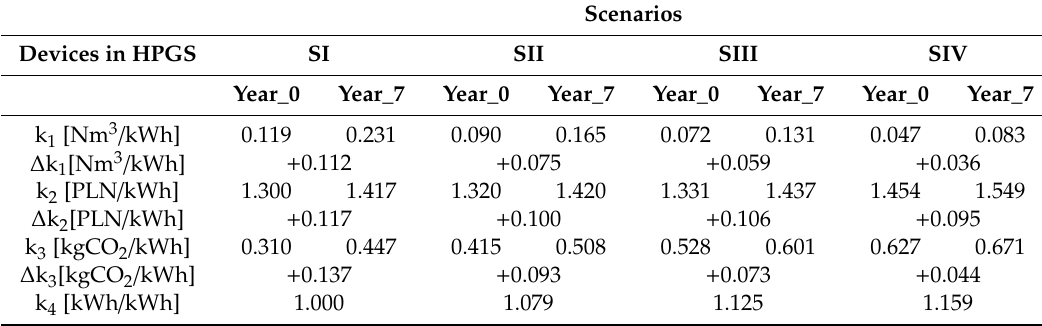
Table 2. Values of decision criteria determined for year 0 and year 7 of HPGS